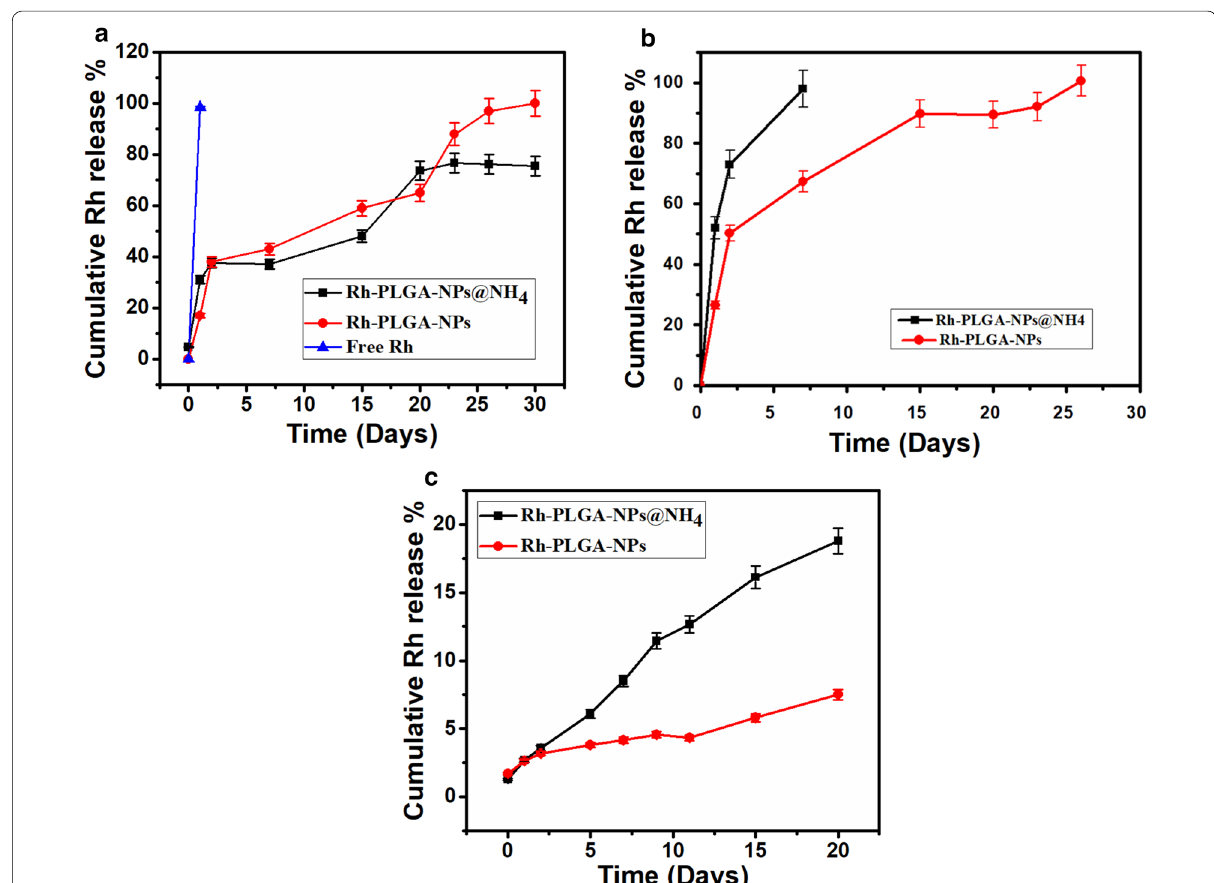
Fig. 3 In-vitro release of Rh from Rh-PLGA-NPs@NH4 and Rh-PLGA-NPs@NH4 in dissolution media phosphate buffer, at different a pH 7.4 b pH 5.4) and c SFE. Data are means S.D., n 03 ± =